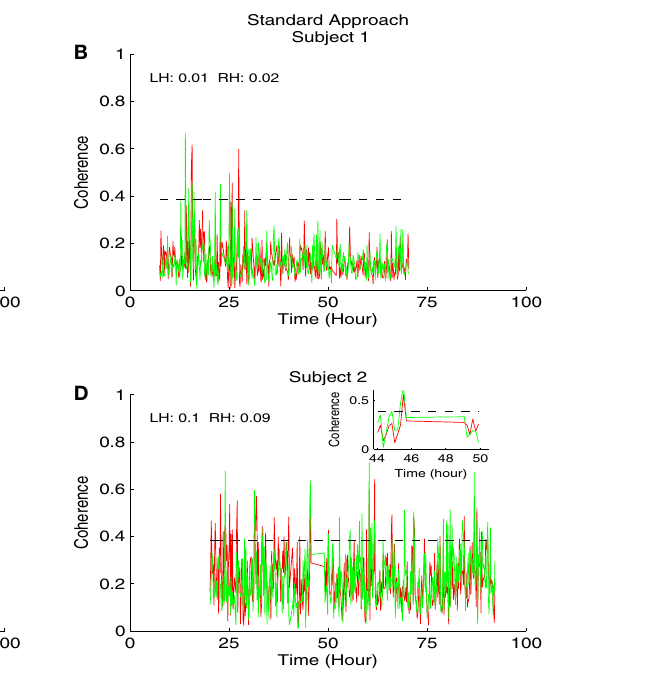
FIGURE 2 | Results of the coherence analysis of MAP and HbD from two newborns from favorable outcome group receiving hypothermia therapy for neonatal encephalopathy .The maximum coherence in 0.05–0.25Hz was shown in all the plots from time since birth. Results from the modified approach were shown in the left side (A,C) and the results from the standard approach were shown in the right side (B,D) . Results from subject 1 were shown in (A,B) and the results from subject 2 were shown in (C,D) . In all the plots, the results from the left hemisphere (LH) were shown in red and the results from the right hemisphere (RH) were shown in green. Also the pressure